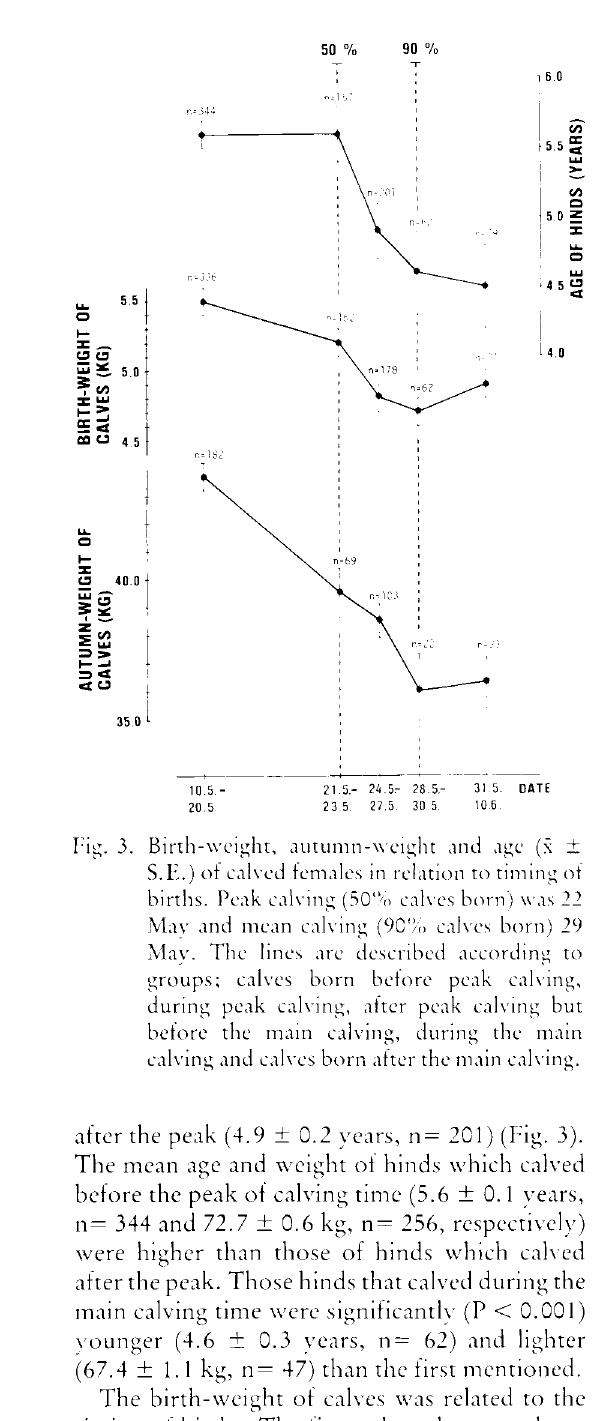
after the peak (4.9 ± 0.2 years, n= 201) (Fig. 3). The mean age and weight of hinds which calved before the peak of calving time (5.6 ± 0.1 years, n= 344 and 72.7 ± 0.6 kg, n= 256, respectively) were higher than those of hinds which calved after the peak. Those hinds that calved during the main calving time were significantly (P < 0.001) younger (4.6 ± 0.3 years, n= 62) and lighter (67.4 ± 1 .1 kg, n= 47) than the first mentioned.